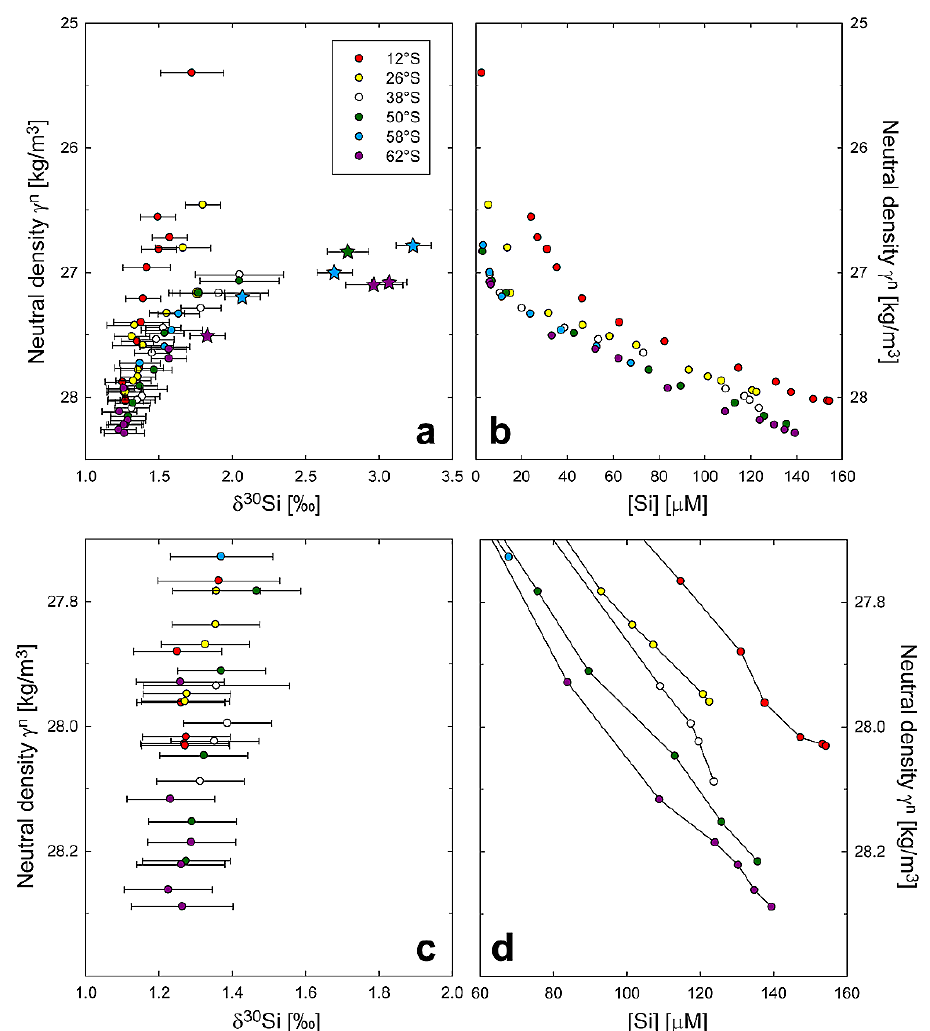
Fig. 5. Profiles of δ 30 Si values ( a and c ) and [Si] ( b and d ) versus neutral density ( γ n ) over the entire sampled water column (upper panels) and below γ n = 27 . 7kgm − 3 . Stars represent high-latitude summer and winter mixed layers (winter mixed layers were identified by the temperature minimum (62 ◦ S) or potential vorticity minimum (58 ◦ S)). Note the different x-axis scales in the upper and lower